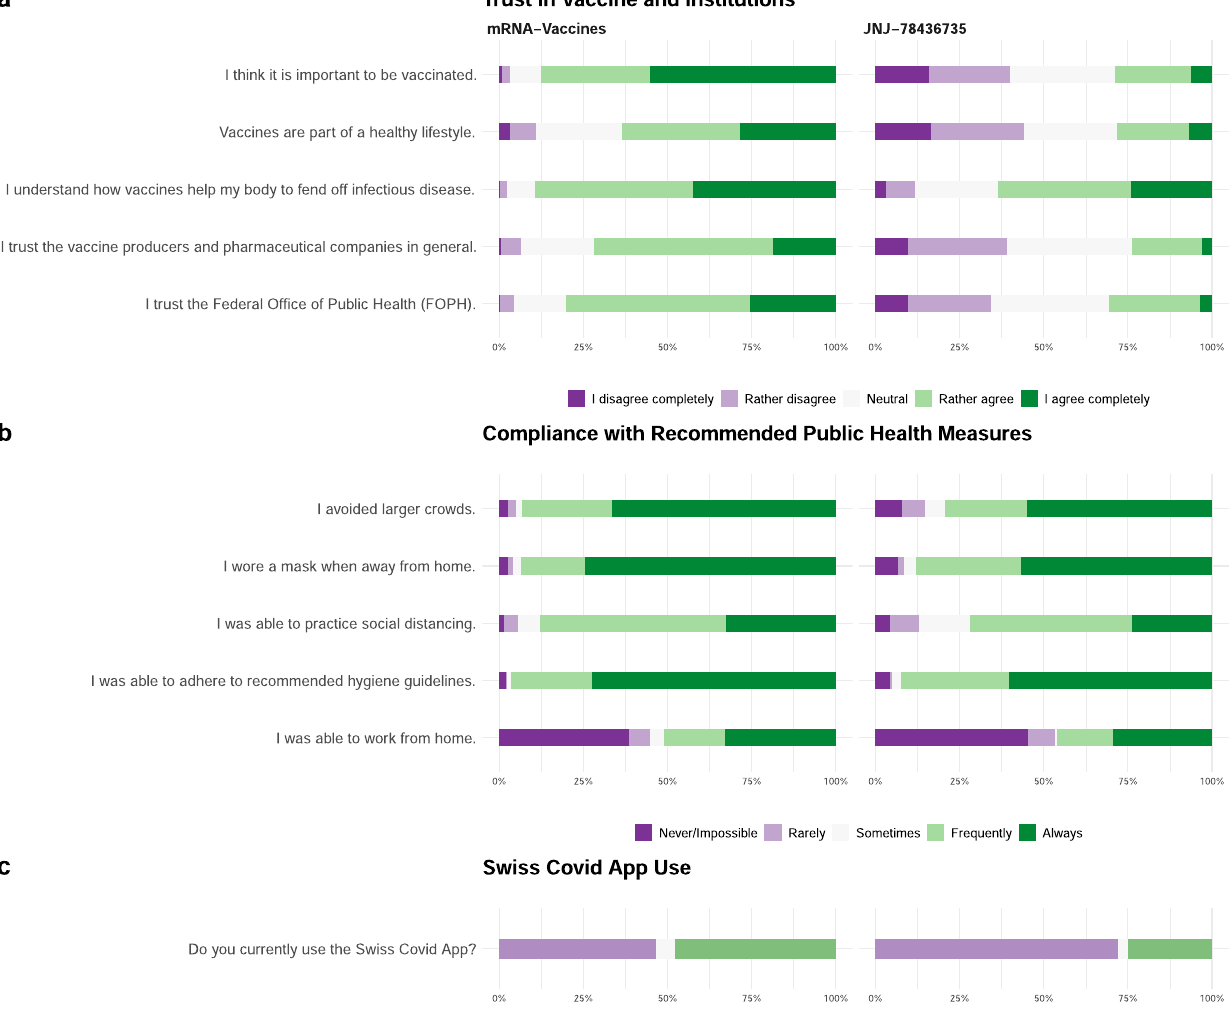
Fig. 3 Perception of vaccination and compliance with recommended public health measures. Panel a shows the attitude of mRNA and JNJ- 78436735 vaccine recipients toward vaccination, pharmaceutical companies and public health authorities. Panel b shows self-reported compliance of mRNA and JNJ-78436735 vaccine recipients to recommended public health measures. Panel c shows self-reported use of Swiss COVID App among mRNA and JNJ-78436735 vaccine